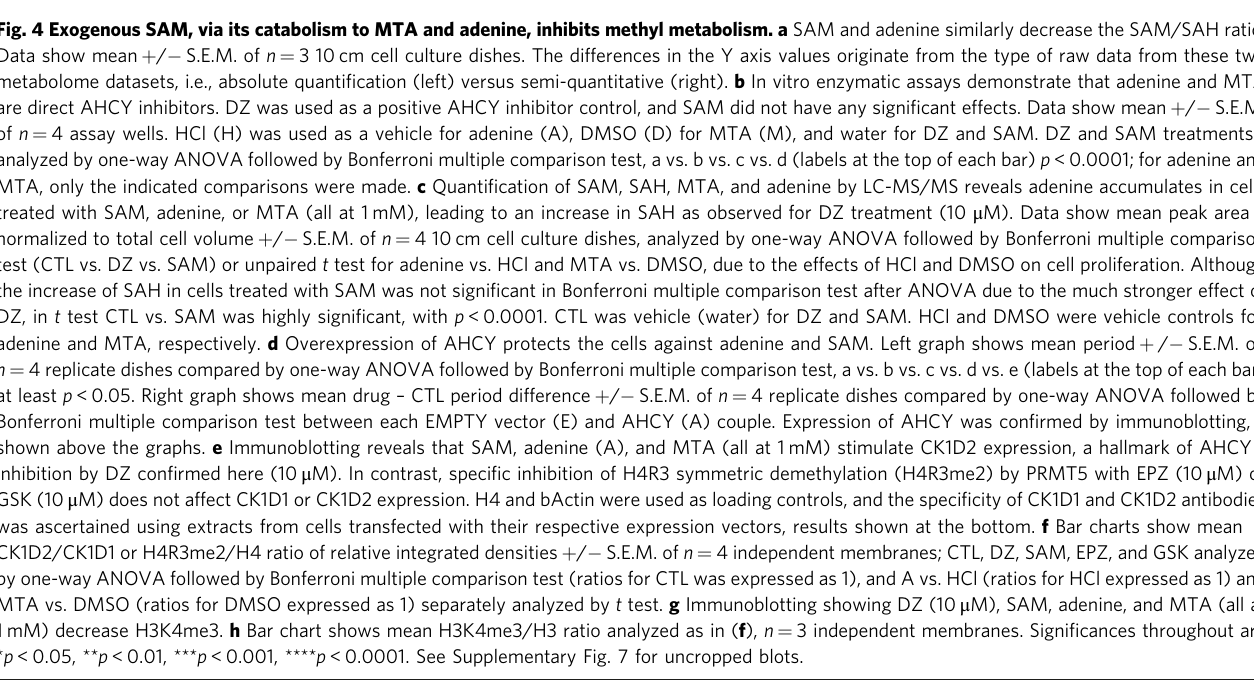
Fig. 4 Exogenous SAM, via its catabolism to MTA and adenine, inhibits methyl metabolism. a SAM and adenine similarly decrease the SAM/SAH ratio. Data show mean + / − S.E.M. of n = 3 10 cm cell culture dishes. The differences in the Y axis values originate from the type of raw data from these two metabolome datasets, i.e., absolute quanti fi cation (left) versus semi-quantitative (right). b In vitro enzymatic assays demonstrate that adenine and MTA are direct AHCY inhibitors. DZ was used as a positive AHCY inhibitor control, and SAM did not have any signi fi cant effects. Data show mean + / − S.E.M. of n = 4 assay wells. HCl (H) was used as a vehicle for adenine (A), DMSO (D) for MTA (M), and water for DZ and SAM. DZ and SAM treatments analyzed by one-way ANOVA followed by Bonferroni multiple comparison test, a vs. b vs. c vs. d (labels at the top of each bar) p < 0.0001; for adenine and MTA, only the indicated comparisons were made. c Quanti fi cation of SAM, SAH, MTA, and adenine by LC-MS/MS reveals adenine accumulates in cells treated with SAM, adenine, or MTA (all at 1 mM), leading to an increase in SAH as observed for DZ treatment (10 μ M). Data show mean peak area normalized to total cell volume + / − S.E.M. of n = 4 10 cm cell culture dishes, analyzed by one-way ANOVA followed by Bonferroni multiple comparison test (CTL vs. DZ vs. SAM) or unpaired t test for adenine vs. HCl and MTA vs. DMSO, due to the effects of HCl and DMSO on cell proliferation. Although the increase of SAH in cells treated with SAM was not signi fi cant in Bonferroni multiple comparison test after ANOVA due to the much stronger effect of DZ, in t test CTL vs. SAM was highly signi fi cant, with p < 0.0001. CTL was vehicle (water) for DZ and SAM. HCl and DMSO were vehicle controls for adenine and MTA, respectively. d Overexpression of AHCY protects the cells against adenine and SAM. Left graph shows mean period + / − S.E.M. of n = 4 replicate dishes compared by one-way ANOVA followed by Bonferroni multiple comparison test, a vs. b vs. c vs. d vs. e (labels at the top of each bar) at least p < 0.05. Right graph shows mean drug – CTL period difference + / − S.E.M. of n = 4 replicate dishes compared by one-way ANOVA followed by Bonferroni multiple comparison test between each EMPTY vector (E) and AHCY (A) couple. Expression of AHCY was con fi rmed by immunoblotting, shown above the graphs. e Immunoblotting reveals that SAM, adenine (A), and MTA (all at 1 mM) stimulate CK1D2 expression, a hallmark of AHCY inhibition by DZ con fi rmed here (10 μ M). In contrast, speci fi c inhibition of H4R3 symmetric demethylation (H4R3me2) by PRMT5 with EPZ (10 μ M) or GSK (10 μ M) does not affect CK1D1 or CK1D2 expression. H4 and bActin were used as loading controls, and the speci fi city of CK1D1 and CK1D2 antibodies was ascertained using extracts from cells transfected with their respective expression vectors, results shown at the bottom. f Bar charts show mean CK1D2/CK1D1 or H4R3me2/H4 ratio of relative integrated densities + / − S.E.M. of n = 4 independent membranes; CTL, DZ, SAM, EPZ, and GSK analyzed by one-way ANOVA followed by Bonferroni multiple comparison test (ratios for CTL was expressed as 1), and A vs. HCl (ratios for HCl expressed as 1) and MTA vs. DMSO (ratios for DMSO expressed as 1) separately analyzed by t test. g Immunoblotting showing DZ (10 μ M), SAM, adenine, and MTA (all